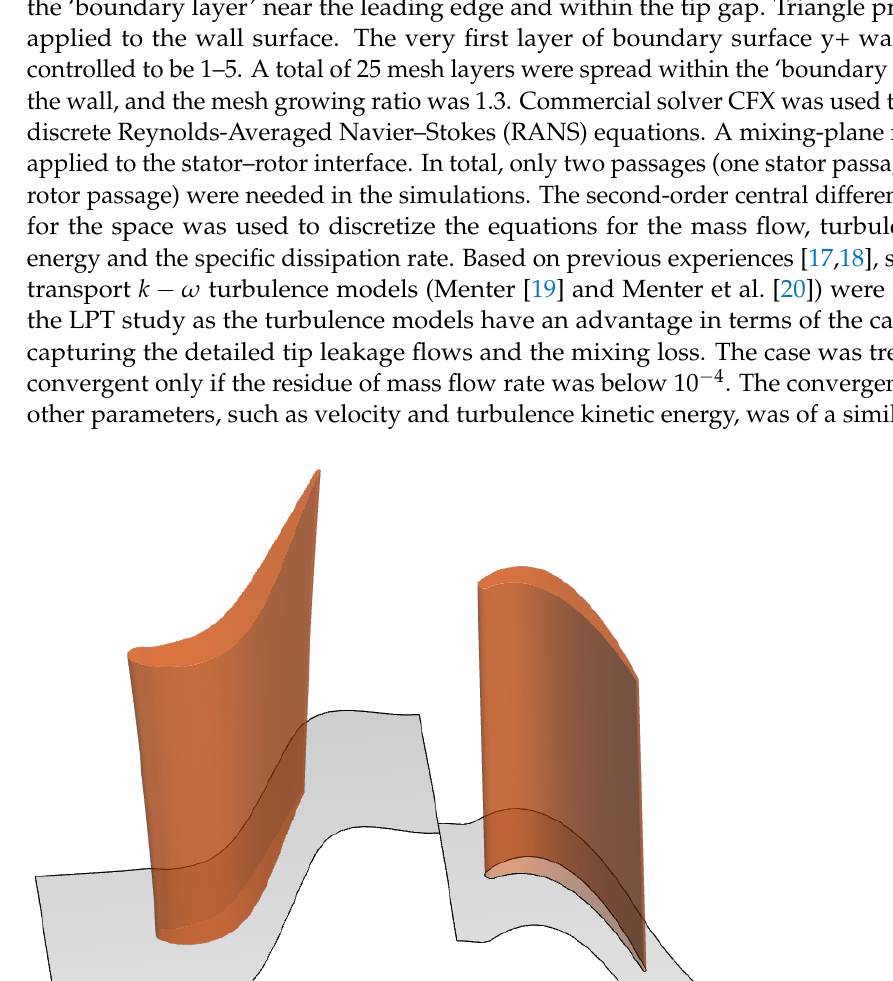
Table 1. Parameters of the low-pressure turbine.